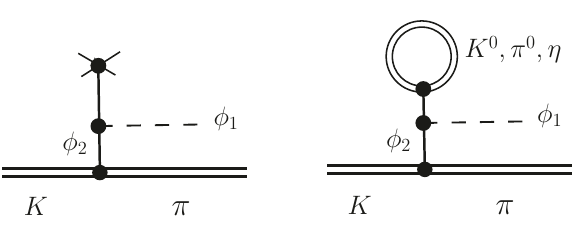
Figure 4 . The contributions to the K the related one-loop tadpole diagram